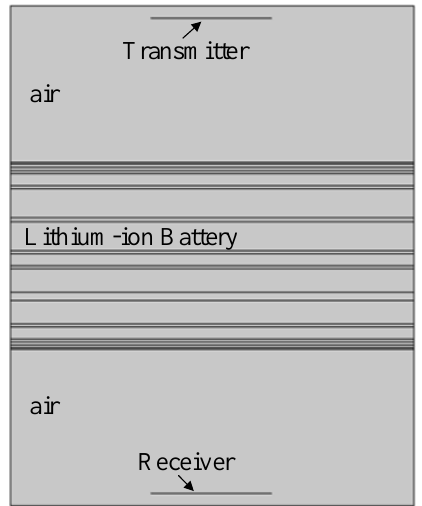
Figure 6. The homogenization finite element model of the lithium-ion battery.